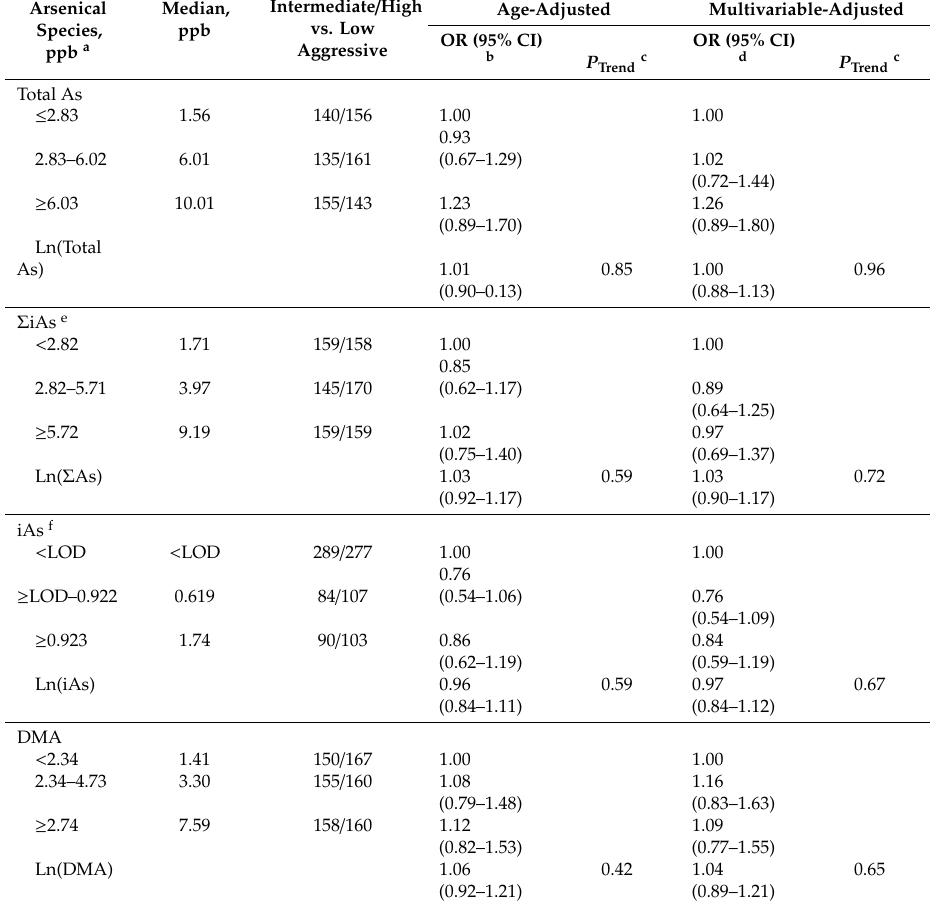
Table 2. Odds ratios (ORs) and corresponding 95% confidence intervals (CIs) for the associations between quantiles of specific gravity-adjusted urinary arsenic concentrations and prostate cancer aggressiveness among PCaP men, ( n =